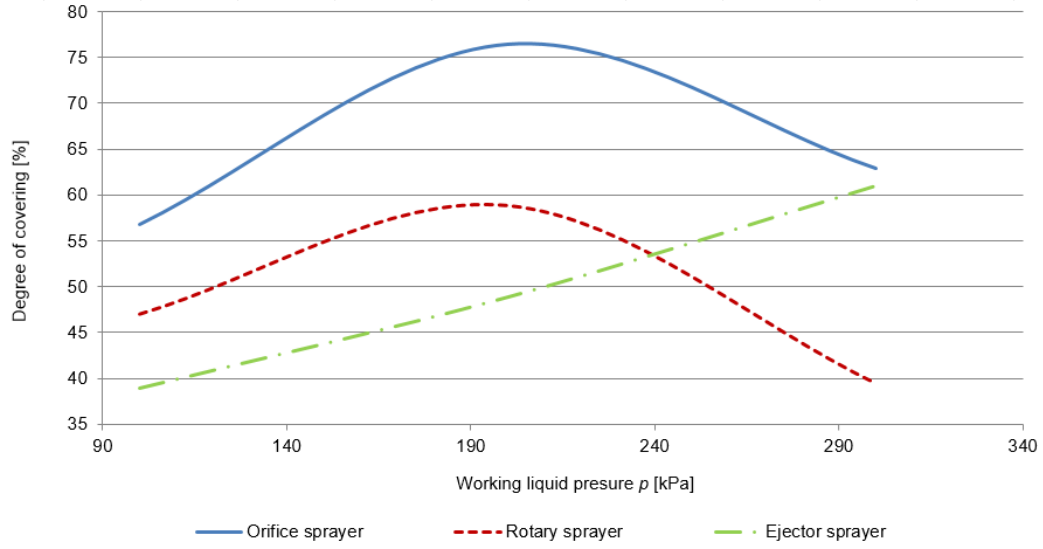
Figure 5. The degree of seed potato covering with the dressing substance for the electronically controlled sprayer valve positioned at a distance S of 50 mm from the seed potato fall axis.